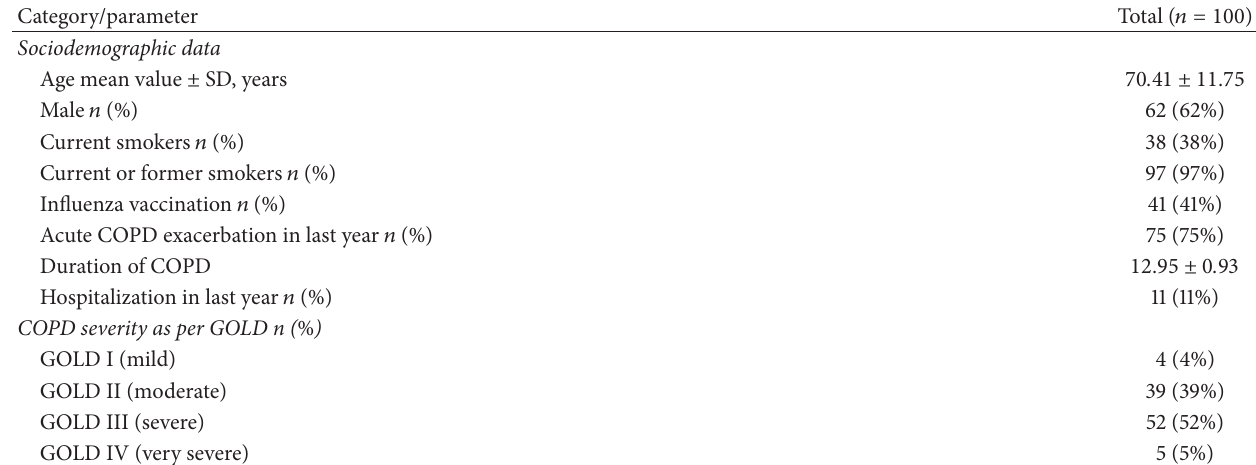
Figure 1: Strategies for screening patients with viral AECOPD. Table 1: Clinical characteristics of